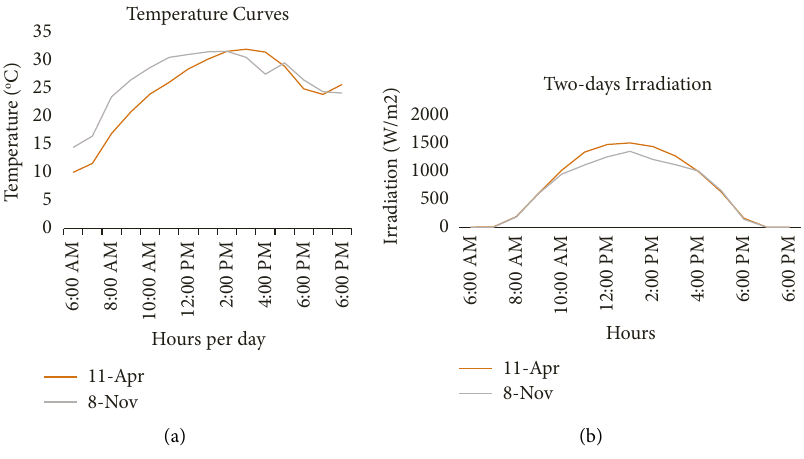
Figure 19: (a) Temperature curves for two days. (b) Solar irradiation.